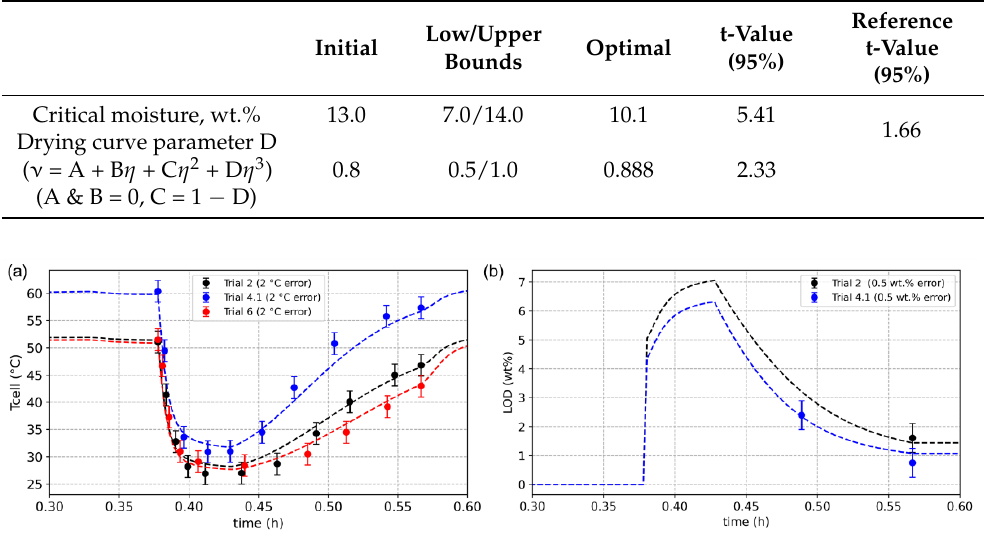
Figure 9. Comparison between predicted and experimental ( a ) cell temperature and ( b ) final LOD value.